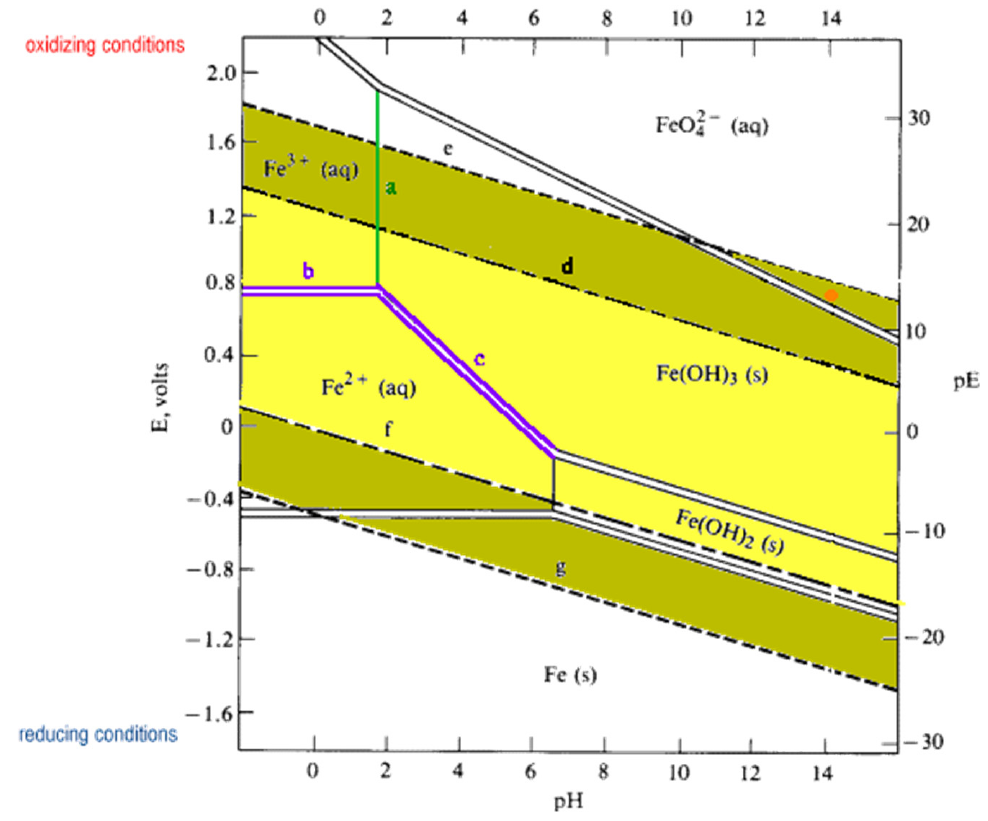
Figure 6. Pourbaix diagram of iron based on 1M ferrate(VI) at 25 °C [117]. The standard reduction potential for Fe(VI)/Fe(III) at pH = 14 is +0.71 V (Standard Hydrogen Electrode, SHE), comparable to the oxidising properties of Fe(III) in acid solution, the potential for the redox pair Fe(III)/Fe(II) being +0.77 V at pH = 0. In theory, any